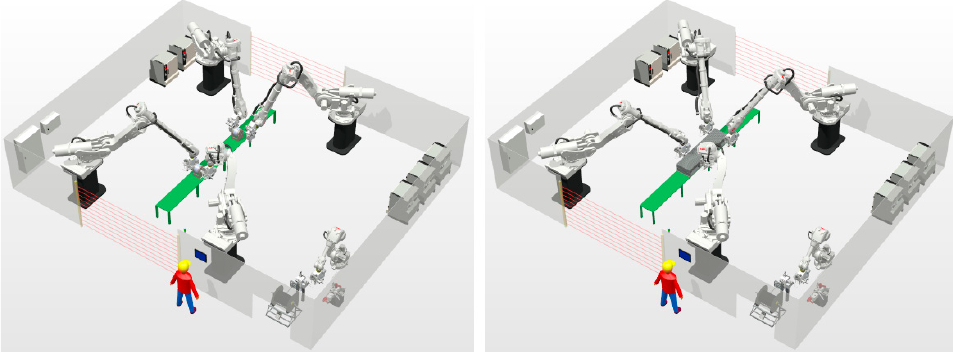
Figure 14. Graphical illustrations from simulations of robotized stator cable winding of two smaller rotating electric machine designs S2a ( left ) and a linear UU Wave Energy Converter stator section ( right ) in the robot cell developed for the larger rotating electric machine designs S1a–c.